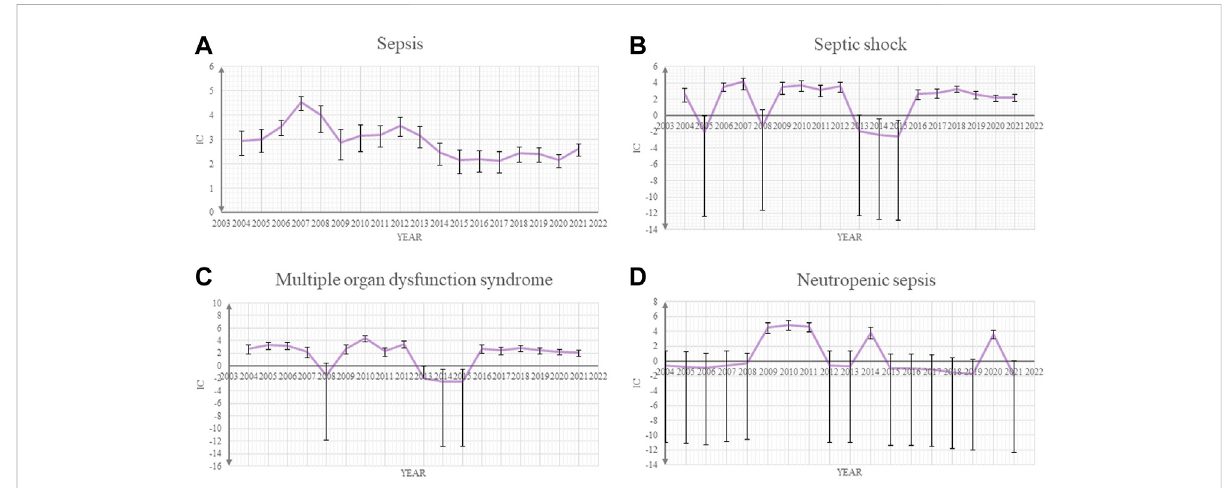
FIGURE 1 Information component (IC) and its 95% credibility interval over time for (A) sepsis, (B) septic shock, (C) multiple organ dysfunction syndrome, and (D) neutropenic